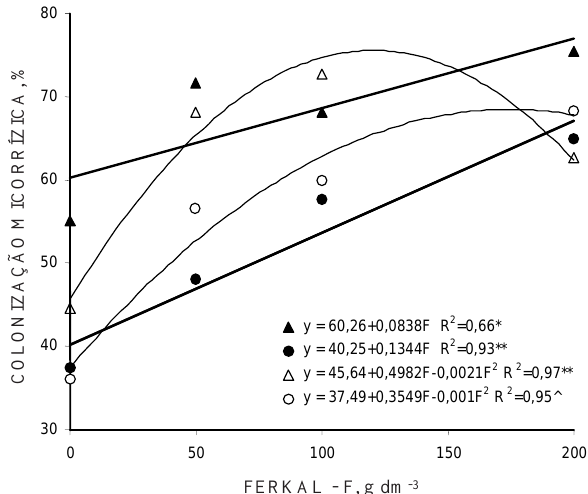
Figura 1. Percentagem do comprimento de raízes de Mimosa caesalpiniaefolia colonizadas por FMAs, nos diferentes tratamentos microbio- lógicos: FMAs nativos; ••••• FMA G. clarum ; DDDDD FMAs nativos + Rizóbio; mmmmm FMA G. clarum + Rizóbio, considerando as doses de Ferkal. Dados transformados: arc sen (X/100) 0,5 . Significativos a 1(**), 5(*) e